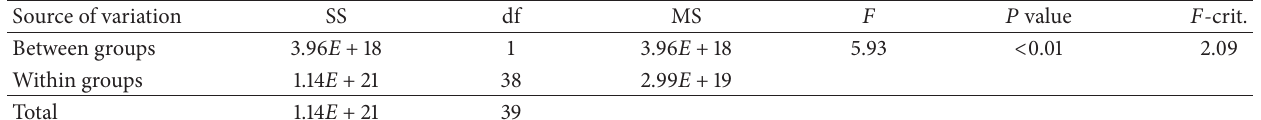
Table 5: One-way ANOVA test results (computational